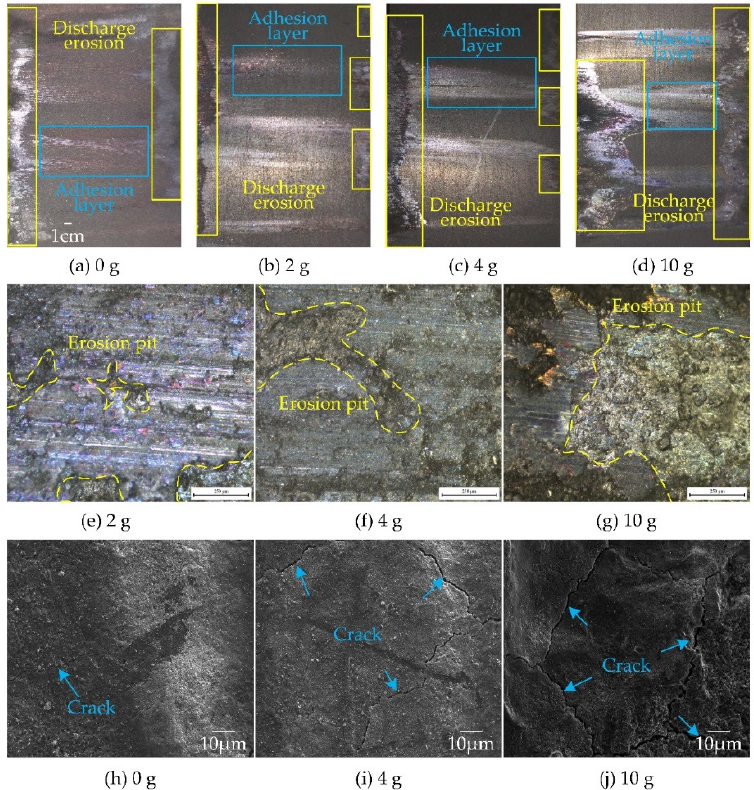
Figure 9. Surface morphology of carbon sliders with the current of 100 A: ( a ) − ( d ) macroscopic feature under different water content; ( e ) − ( g ) metallurgical microscope image of the discharge erosion pit; ( h ) − ( j ) SEM image of the micro-cracks.